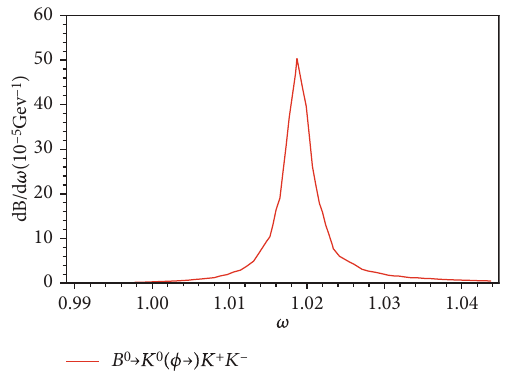
Figure 3: The ω -dependence of di ff erential branching fractions for the B 0 ⟶ K 0 K + K − decay